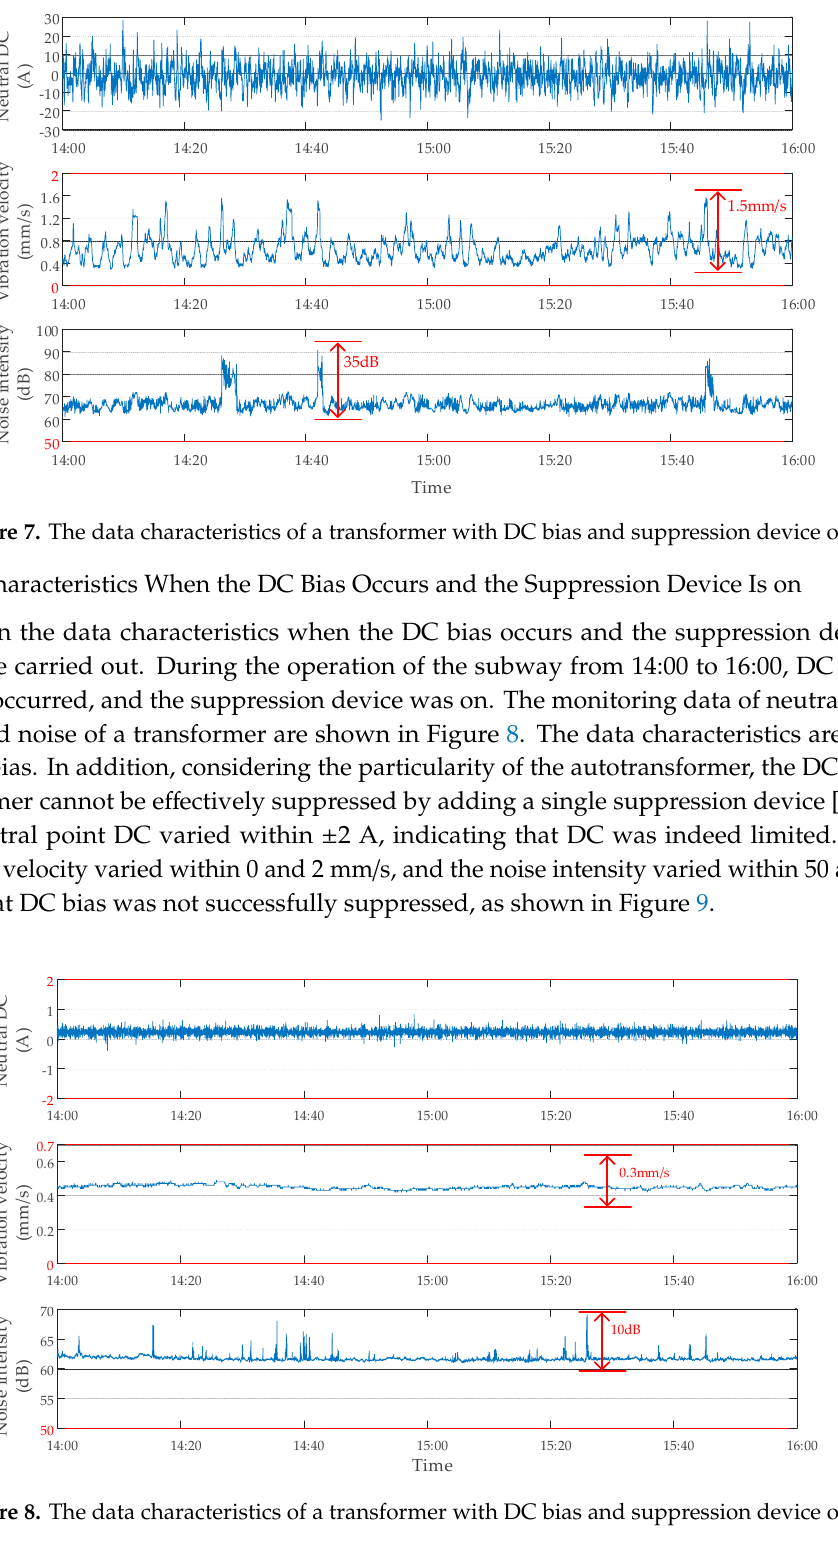
When DC bias of transformer occurred, the use of the DC bias suppression device had a great influence on the monitoring data [25–27]. To obtain the data characteristics when the DC bias occurred and the suppression device was off, the tests were carried out. During the operation of the subway from 14:00 to 16:00, DC bias of the transformer occurred , and the suppression device was off. The monitoring data of neutral point DC, vibration, and noise of a transformer are shown in Figure 7. The neutral point DC fluctuated within ±90 A. Vibration velocity was within 0 and 2 mm/s, and the maximum variation amplitude did not exceed 1.5 mm/s. The noise intensity was within 50 and 110 dB, and the maximum variation range did not exceed 35 dB.